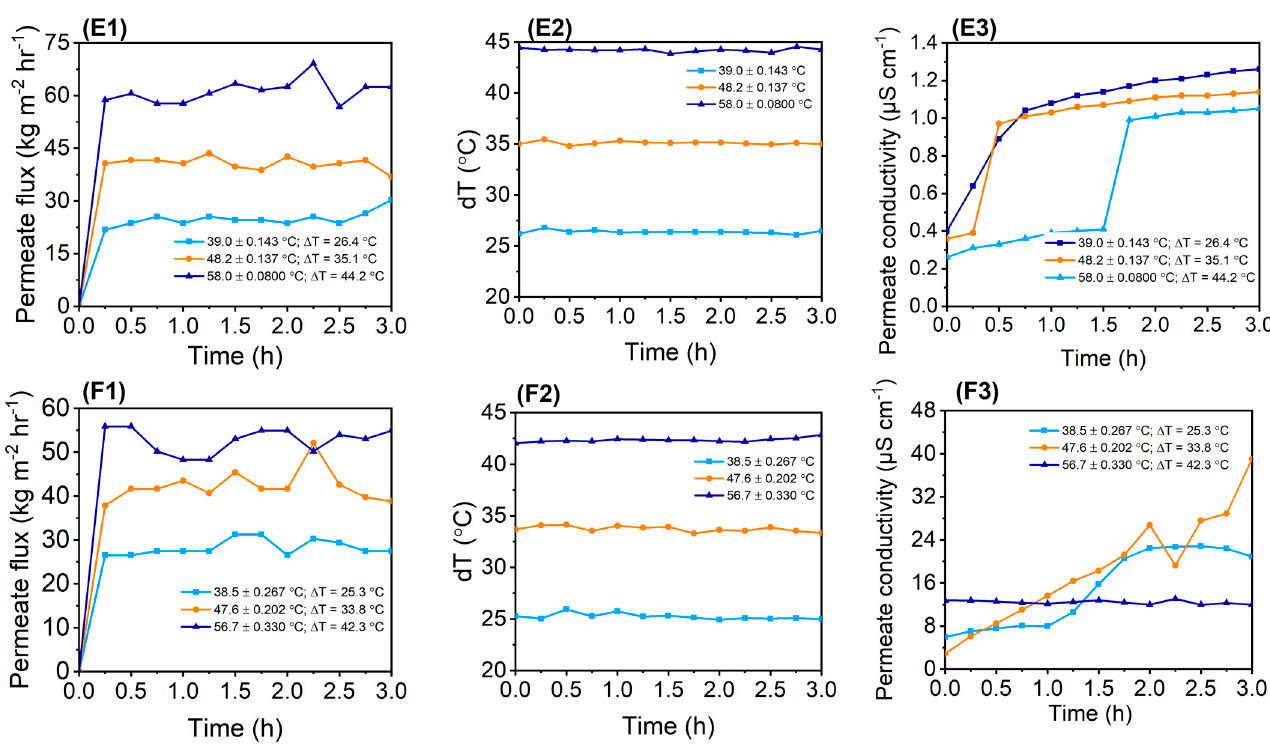
Figure 5. Permeate flux, deltaT, permeate conductivity vs. time at various temperatures for water desalination in DCMD: ( A1 − A3 ) M1, ( B1 − B3 ) M2, ( C1 − C3 ) M3, ( D1 − D3 ) M4, ( E1 − E3 ) PTFE-20, and ( F1 − F3 ) PTFE-45.